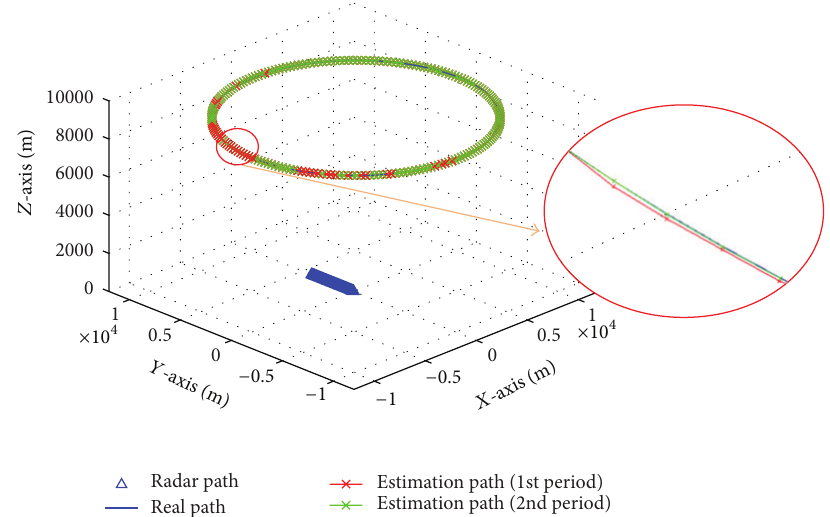
Figure 15: 3D scenario diagram of Case